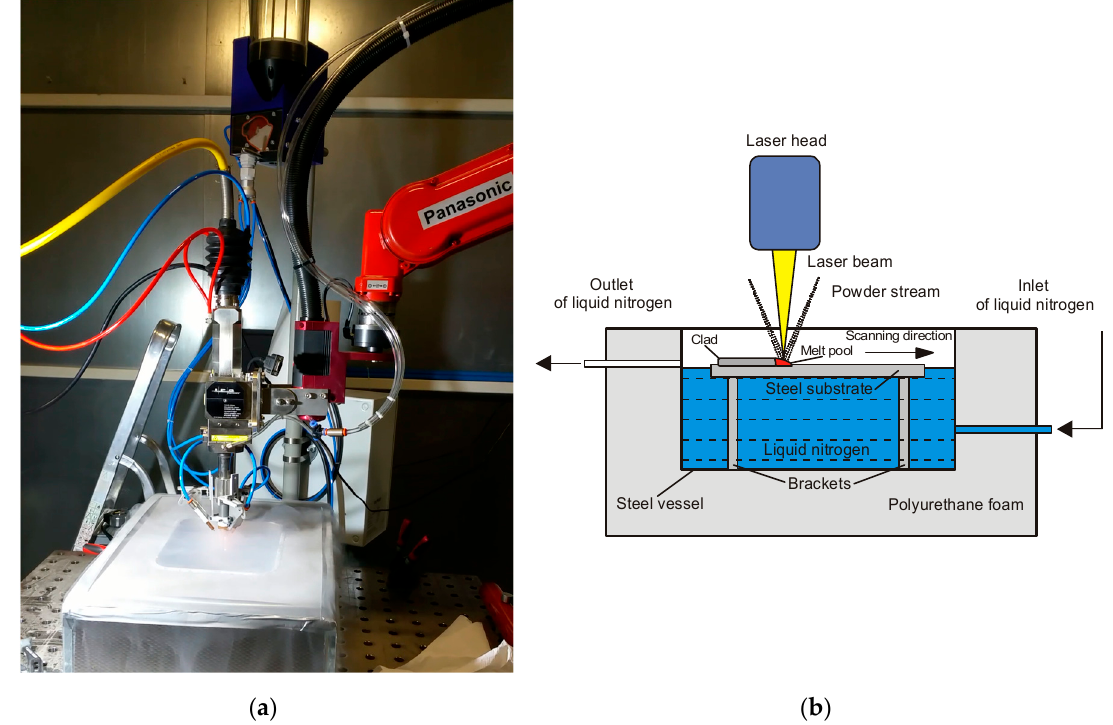
Figure 2. ( a ) A view of the laser powder deposition process under cryogenic conditions on the experimental stand for technological tests of laser cladding and powder deposition equipped with a six-axis robot, an high power fiber laser (HPFL), powder dosing, and a delivery system with a specially designed powder head with three individual adjustable nozzles and a bath of liquid nitrogen for cooling the substrate; ( b ) a scheme for the laser powder deposition of a steel specimen immersed in a liquid nitrogen